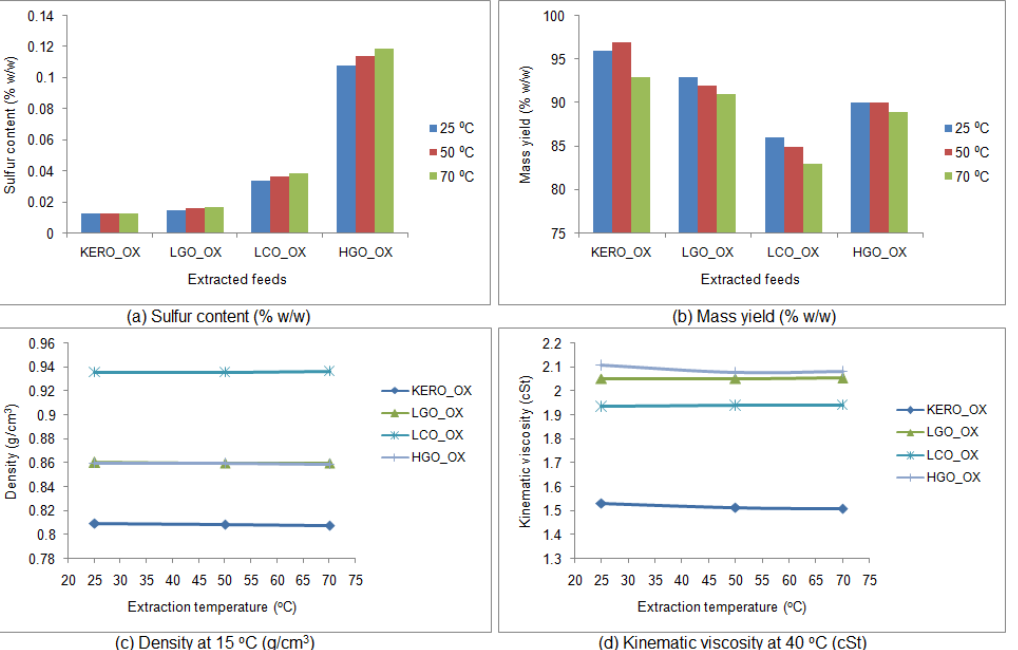
Figure 10. Influence of temperature on the desulfurization capability of the fresh [BMIM][Br]: ( a ) sulfur content of the surrogate raffinates (% w / w ), ( b ) mass yield of the surrogate raffinates (% w / w ), ( c ) density of the surrogate raffinates at 15 ◦ C (g/cm 3 ), ( d ) kinematic viscosity of the surrogate raffinates at 40 ◦ C (cSt). (KERO_ OX: oxidized surrogate kerosene, LGO_OX: oxidized surrogate LGO, LCO_OX: oxidized surrogate LCO, HGO_OX: oxidized surrogate HGO).